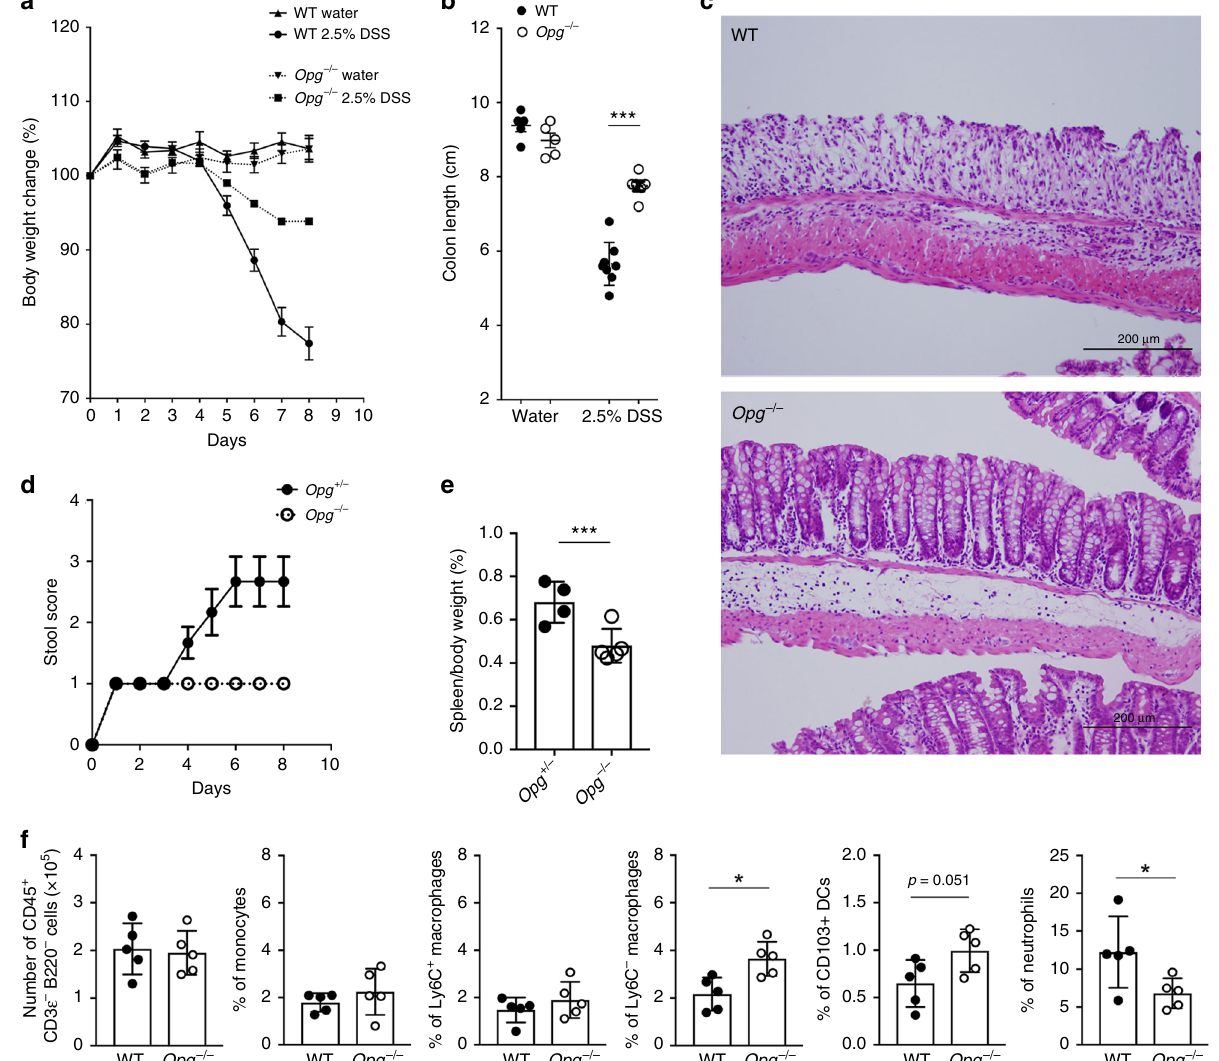
Fig. 6 Absence of Opg ameliorates DSS-induced colitis. a Daily changes in body weight during dextran sodium sulfate (DSS)-induced colitis. Changes in body weight percentage were calculated by dividing the body weight on the speci fi ed day by the body weight at day 0. b Colon length was measured after sacri fi ce at day 8. c Representative histology of hematoxylin- and eosin-stained colonic tissue from WT and Opg − / − mice with DSS-induced colitis on day 8. d Stool scores were measured as described in the Methods. e Spleen weight was measured after sacri fi ce at day 8. a , b , d , and e Data are presented as the mean ± SEM. ** p < 0.01, *** p < 0.005 (Student ’ s t -test, n = 5 animals). Similar results were obtained from three independent experiments, and representative data are shown. f The number of CD45 + CD3 ε − B220 − cells and the frequency of monocytes, Ly6C + macrophages, Ly6C − macrophages, CD103 + dendritic cells (DCs), and neutrophils in the population of CD45 + CD3 ε − B220 − cells of the colonic lamina propria were quanti fi ed by fl ow cytometry. Data are representative of three independent experiments and are presented as the mean ± standard deviation. * p < 0.05; Student ’ s t -test, n = 5 animals. The source data underlying panels a , b , d , e and f are provided as a Source Data fi